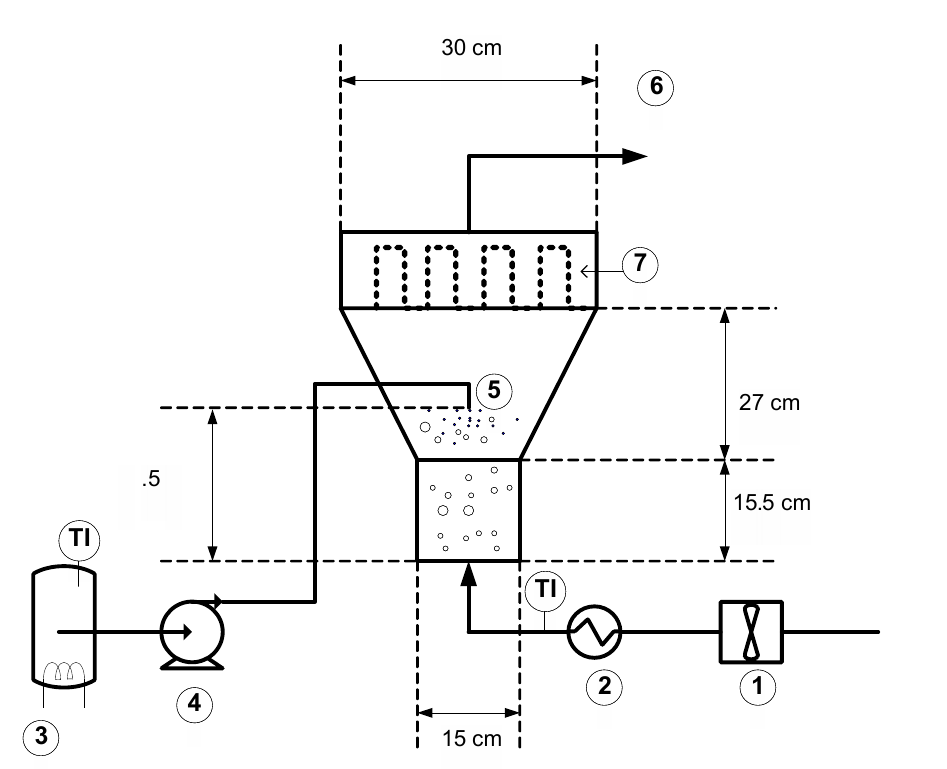
Fig. 2. Experimental setup of fluidized bed granulator: (1) air blower; (2) air heater; (3) binder vessel; (4) binder pump; (5) bind